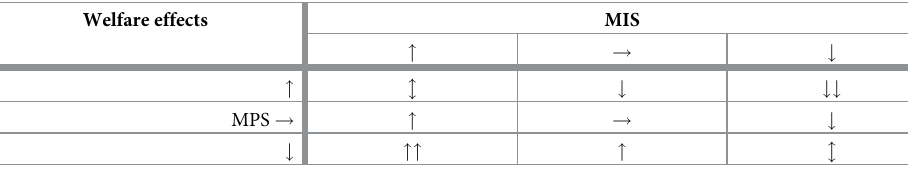
Table 2. Relative welfare effects of MPS & MIS